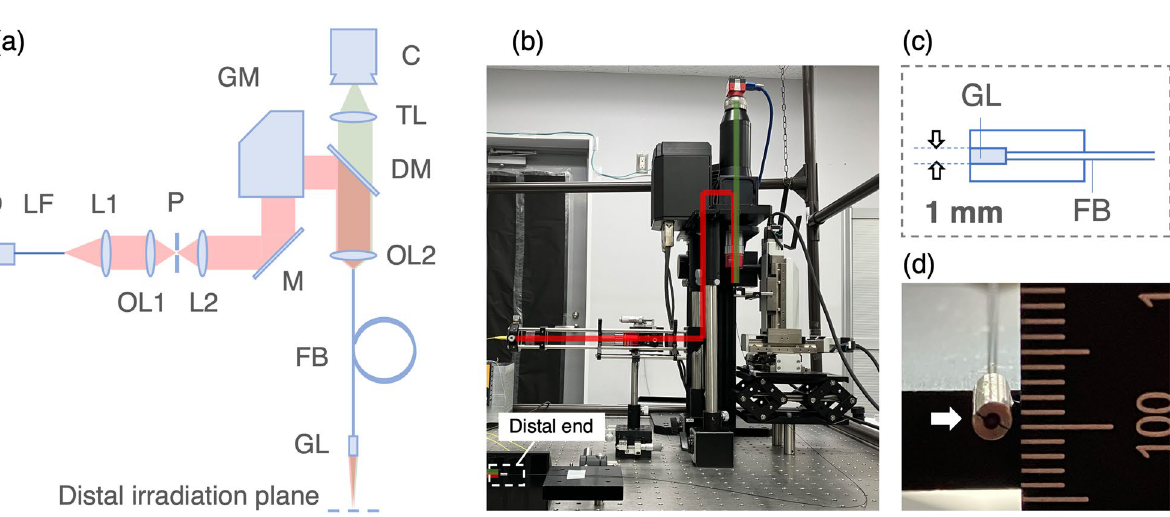
Figure 2. Endoscopic image-guided laser treatment system based on fiber bundle laser steering. ( a ) Schematic illustration of optical setup. The figure was generated by the authors with Microsoft Power Point for Mac (v. 16.69.1) 35 . ( b ) The constructed setup. Red and green lines indicate optical path for laser irradiation and imaging, respectively. ( c ) Internal structure of the distal end. ( d ) External view of the distal end. LD, laser diode; LF, laser fiber; L1, L2, lens; P, pinhole; OL1, OL2, objective lens; M, mirror; GM, galvo mirror system; DM,